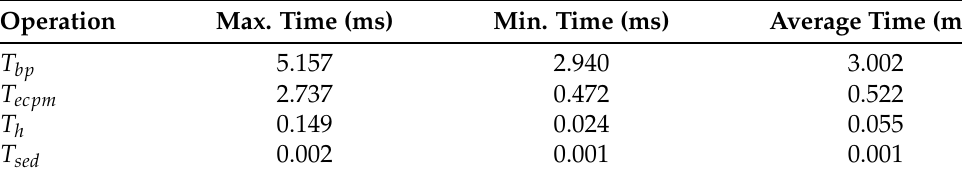
Table 4. Execution time for a server.